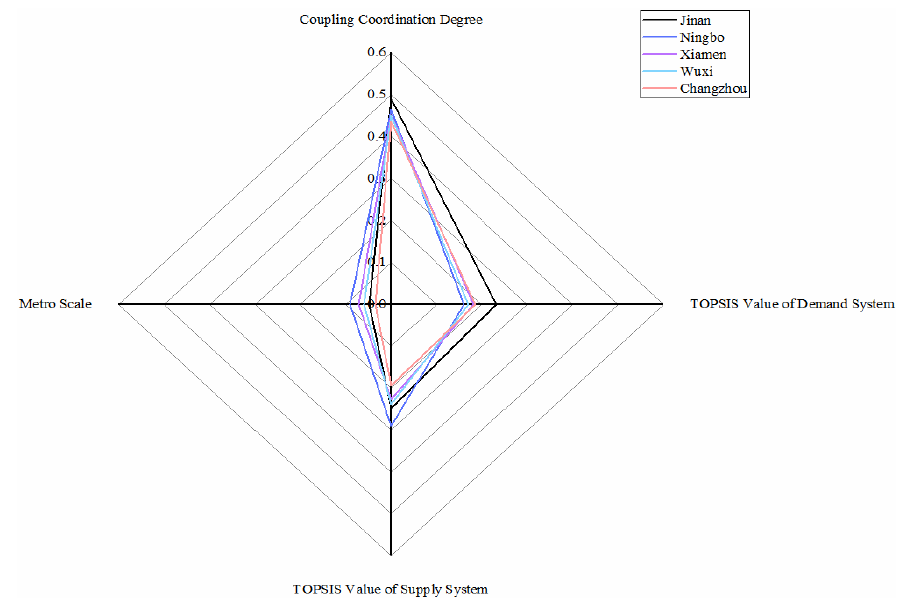
Figure 7. Metros in slightly unbalanced with lagging demand conditions.